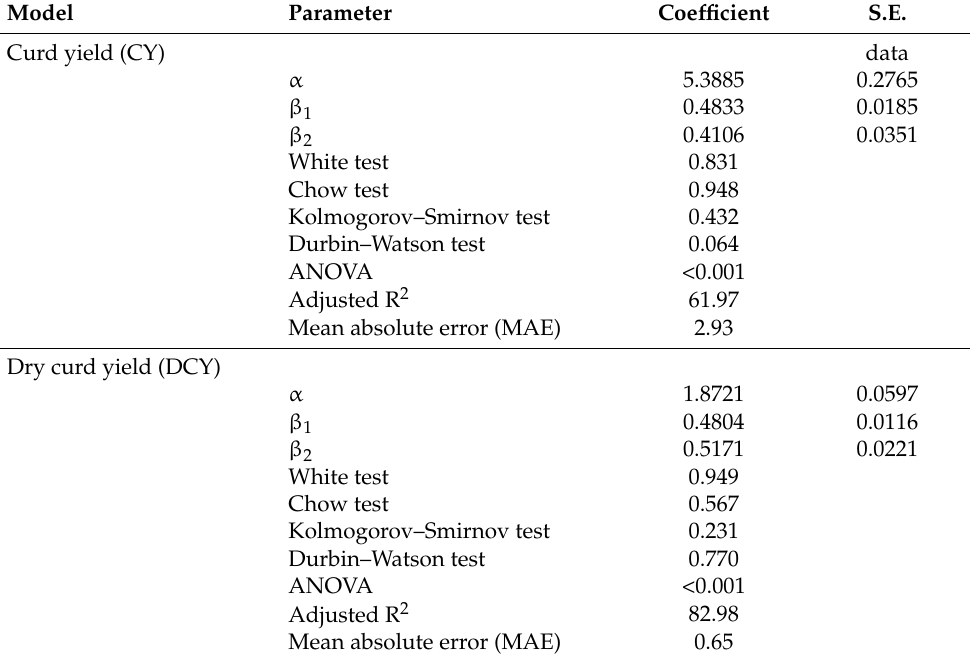
Table 1. Adjusted regression models between the observed values ( Y ) for curd yield (CY) and dry curd yield (DCY), and fat ( X 1 ) and protein ( X 2 ) content of Manchega sheep milk ( n =